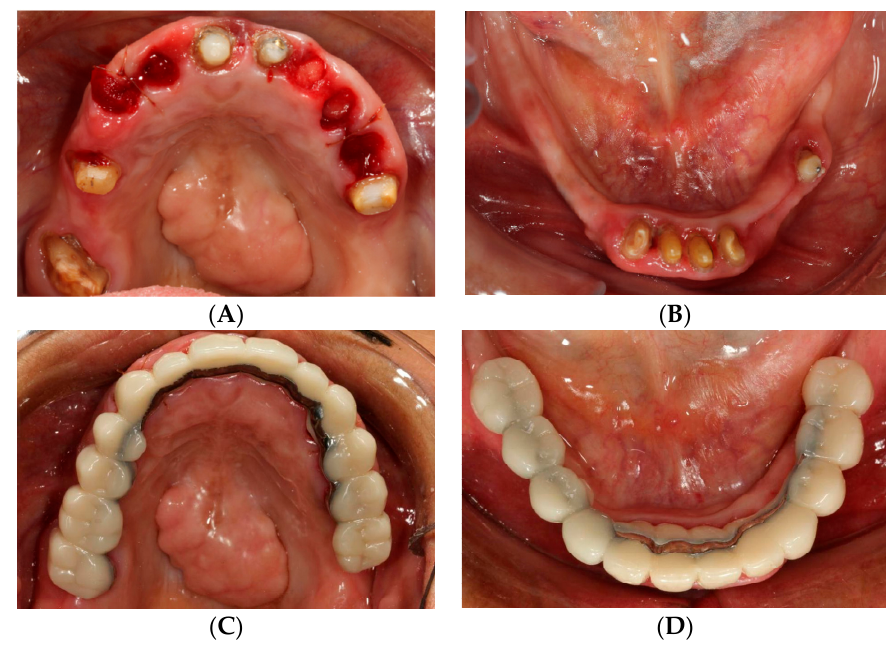
Figure 2. Strategic extraction and tooth-supported fixed provisional prosthesis. ( A ) Maxillary view after strategic extraction. ( B ) Mandibular view. ( C ) Maxillary view with tooth-supported fixed provisional prosthesis. ( D ) Mandibular